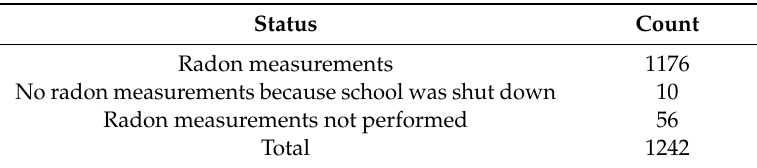
Table 3. Status of the schools with radon measurement obligation reported to STUK and whether the indoor radon measurements were carried out by March